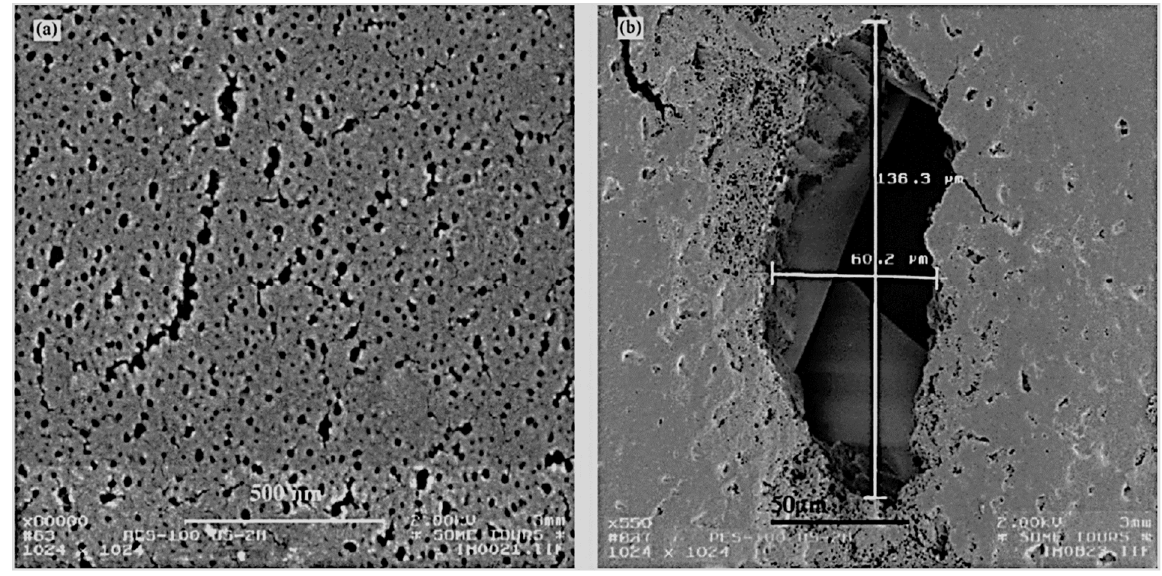
Figure 11. Microscopic image of the PES (100 kDa) membrane surface after being sonicated at 47 kHz for 2 h ( a ) with an 80,000 magnification; ( b ) a heavily damaged area with a 550 magnification [88].